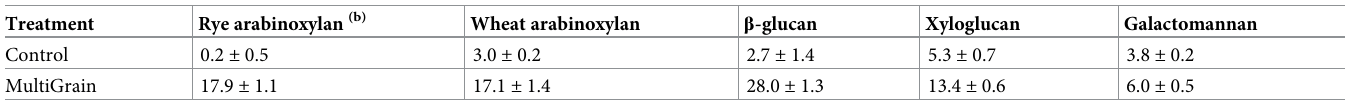
Table 2. Viscosity reduction of solutions of rye- and wheat-arabinoxylan, β -glucan, xyloglucan and galactomannan upon treatment with MultiGrain (a) .